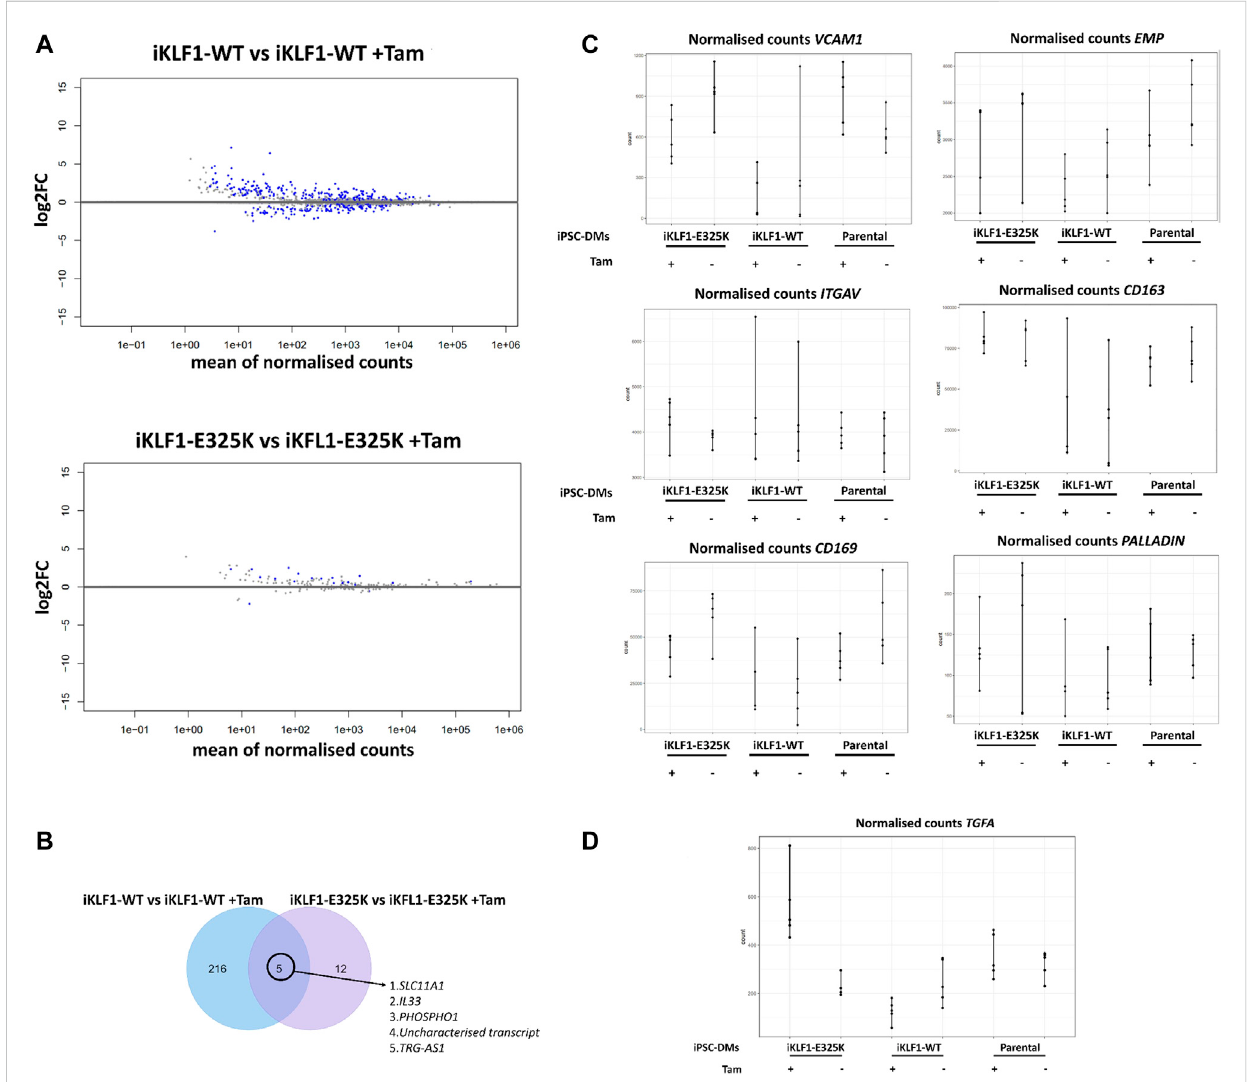
FIGURE 4 KLF1-E325K induces transcriptional changes in iPSC-DMs. (A) Volcano plots for speci fi ed contrasts illustrating up-and downregulated genes by Log2FC. Blue dots represent individual genes passing with an adjusted p -value below 0.05. (B) Venn diagram of genes upregulated in 4OH-tamoxifen treated iKLF1-WT iPSC-DMs and genes upregulated in 4OH-tamoxifen treated iKLF1-E325K iPSC-DMs. (C) Normalised counts shown for all 30 samples for the following genes encoding EBI macrophage attachment proteins: VCAM1, EMP/MAEA, ITGAV, CD163, CD169 and PALLADIN. (D) Normalised counts shown for all 30 samples for